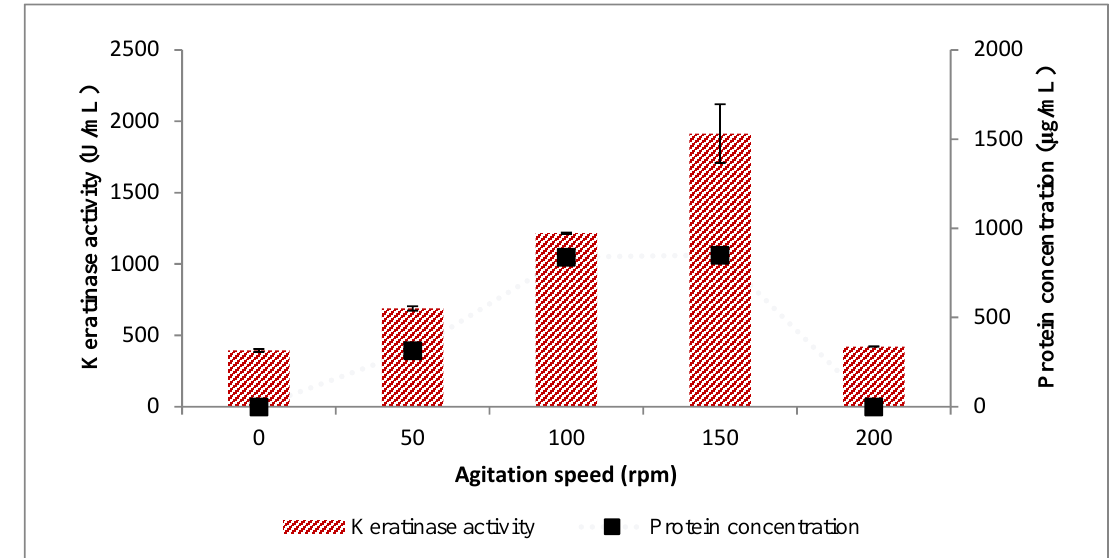
Figure 8. The effect of agitation speed on keratinase activity by Bacillus sp. FPF-1. Figure 8. The e ff ect of agitation speed on keratinase activity by Bacillus sp.